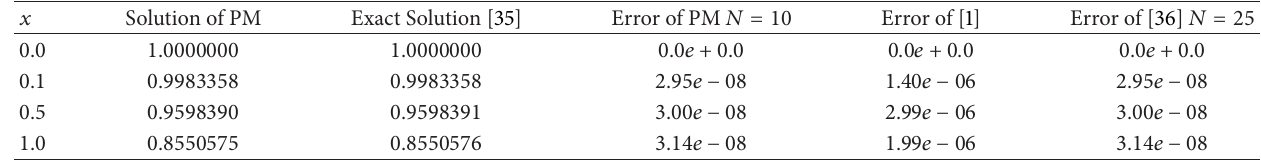
Table 3: The exact and approximated solution of Example 5 together with the error comparisons.